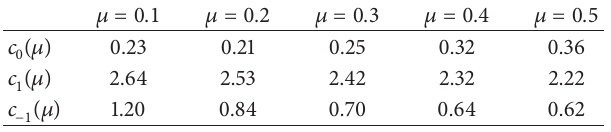
Table 1: The value of 𝑐 0.4, and 0.5.